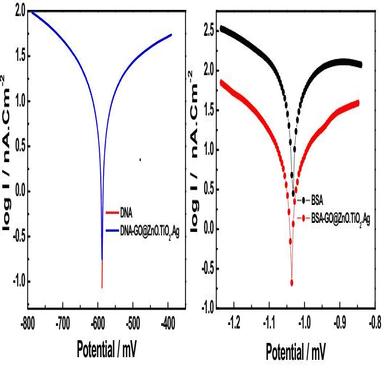
Tafel curve of DNA-GO@ TiO2. ZnO.Ag (left) and BSA- GO@ TiO2. ZnO.Ag (right).